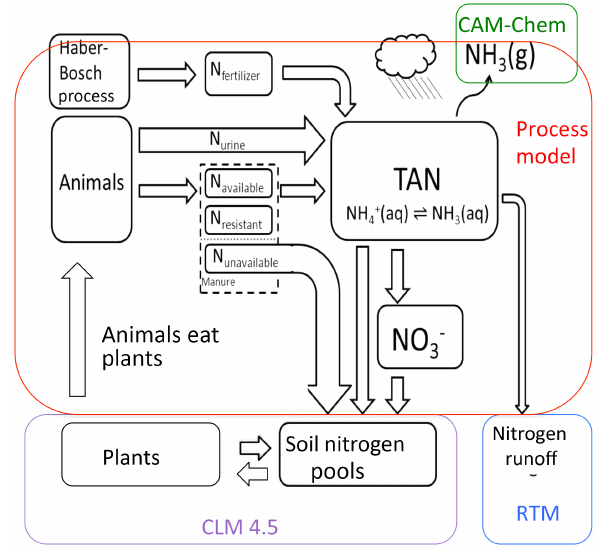
Figure 1. Schematic of the addition of the FAN (flow of agricultural nitrogen) process model to the CESM nitrogen cycle. Some minor pathways are not shown. Soil nitrogen pools and plant nitrogen ex- ist in CLM4.5. Urine nitrogen (N urine ) is directly input to the TAN pool, while fecal matter is split into three parts that decompose into the TAN pool at a rate determined by their C:N ratio (N available , N resistant , N unavailable ). Manure nitrogen that does not mineralize (N unavailable ) is added to the soil organic nitrogen pool. Nitrogen applied as synthetic fertilizer is added to the N fertilizer pool where it decomposes into the TAN pool. Losses from the TAN pool in- clude ammonia (NH 3 ) emission (into CAM-chem), nitrogen runoff ) formation and diffusion to the soil (into the RTM), nitrate (NO − 3 nitrogen